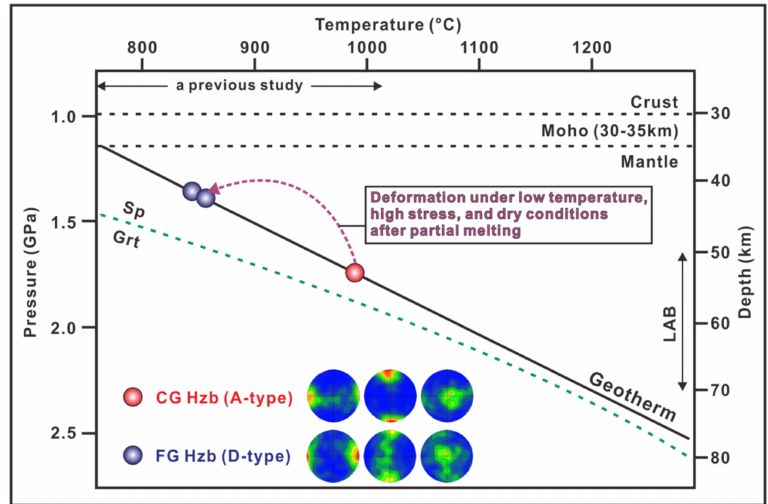
Figure 7. A summary figure showing the relationship between olivine fabrics and deformation conditions in the Baekdusan peridotites. The equilibrium temperatures are projected onto the geotherm (solid line) of the Bohai Bay Basin in the NCC [74]. The spinel (Sp)–garnet (Grt) phase transformation (green dashed line) is from O’Reilly and Gri ffi n [76]. The crust–mantle boundary (Moho) depth (30–35 km; black dashed lines) and lithosphere–asthenosphere boundary (LAB) depth (50–70 km) beneath the Baekdusan volcano are from Kim et al. [75]. The equilibrium temperature range indicated by previous data from the Baekdusan peridotite xenoliths is also shown [21]. Coarse-granular (CG) and fine-granular (FG) harzburgite (Hzb). Representative A-type and D-type LPOs of olivine from BD-19 and BD-17,